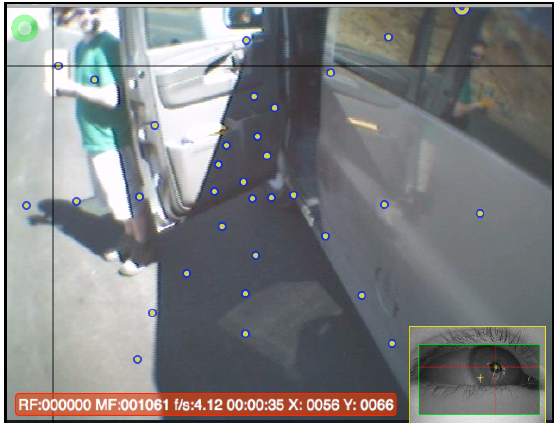
Figure 5. Moving target method of five-point calibration. Observers who were tracked outdoors followed a partner’s moving thumb, which paused at positions that create a five- point calibration (indicated by overlaid circles).